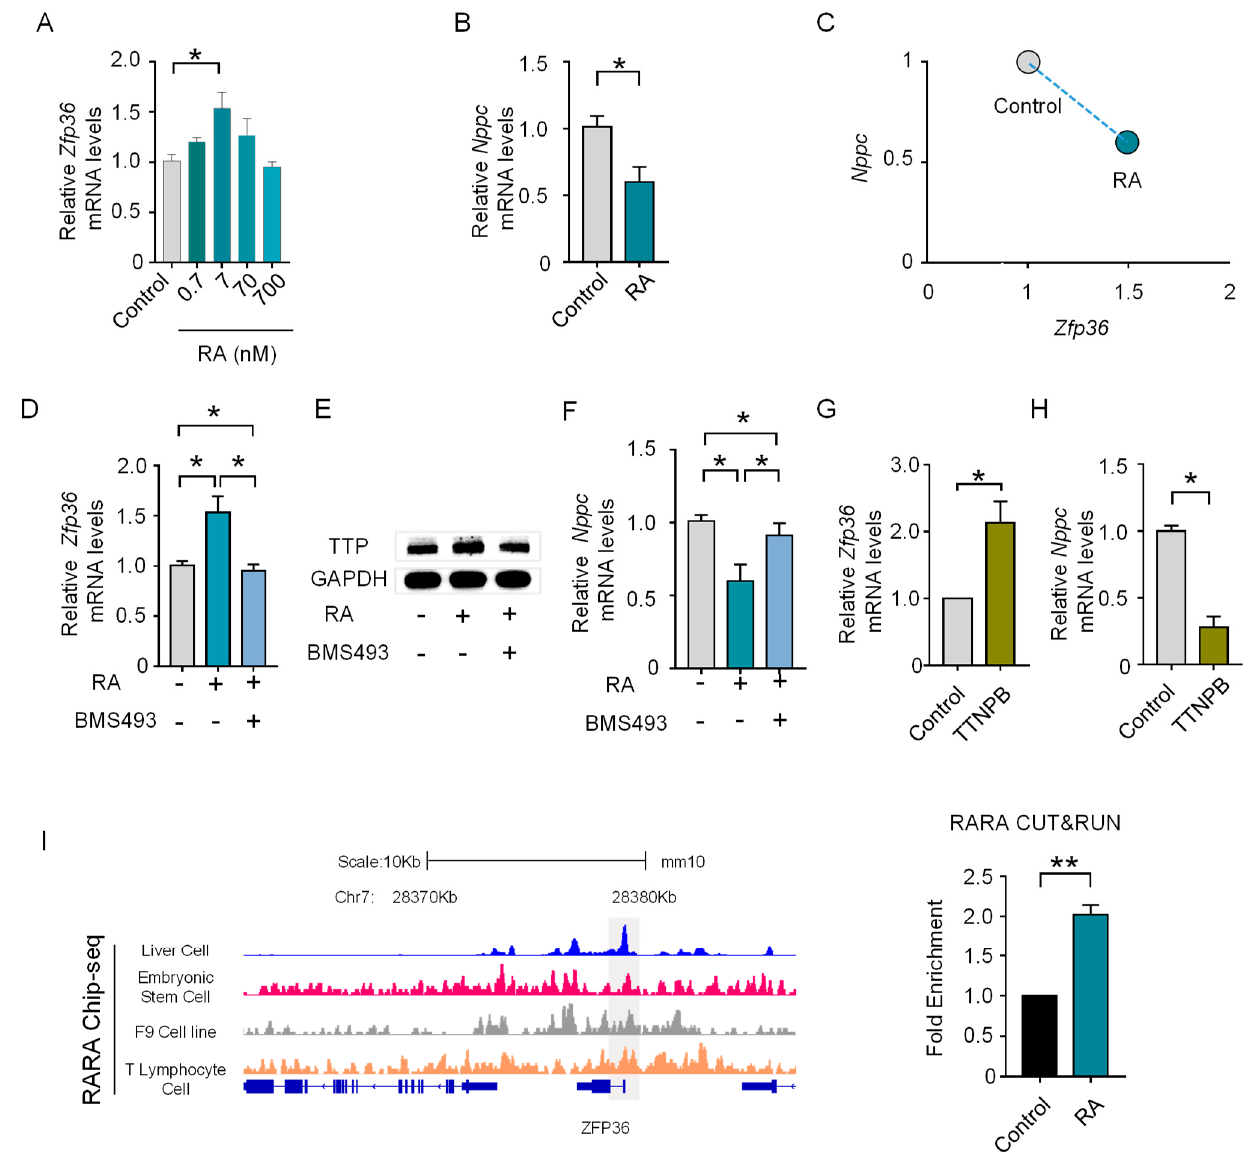
Figure 5. RA promotes the expression of Zfp36 in MGC via RAR. ( A ) The mRNA levels of Zfp36 in MGCs cultured with or without different concentrations of RA. * p < 0.05 ( B ) The mRNA levels of Nppc in MGCs cultured with or without 7 nM RA. * p < 0.05 ( C ) The negative correlation between Zfp36 and Nppc expression levels in MGCs cultured with or without 7 nM RA. ( D ) The mRNA levels of Zfp36 in MGCs cultured with RA alone or together with 1 µ M BMS493. * p < 0.05 ( E ) The Western blotting analysis of TTP in MGCs cultured with RA alone or together with BMS493. * p < 0.05 ( F ) The mRNA levels of Nppc in MGCs cultured with RA alone or together with 1 µ M BMS493. * p < 0.05 ( G , H ) The mRNA levels of Zfp36 ( F ) and Nppc ( G ) in MGCs cultured with or without 0.1 μ M TTNPB. * p < 0.05 ( I ) The IGV screenshots (left) of examples of RARA Chip-seq analysis in different cells collected by the Cistrome data browser and the RARA binding sites are highlighted by the grey area. The right panel showed the RARA CUT&RUN results by detecting the highlighted area. ** p < 0.01.